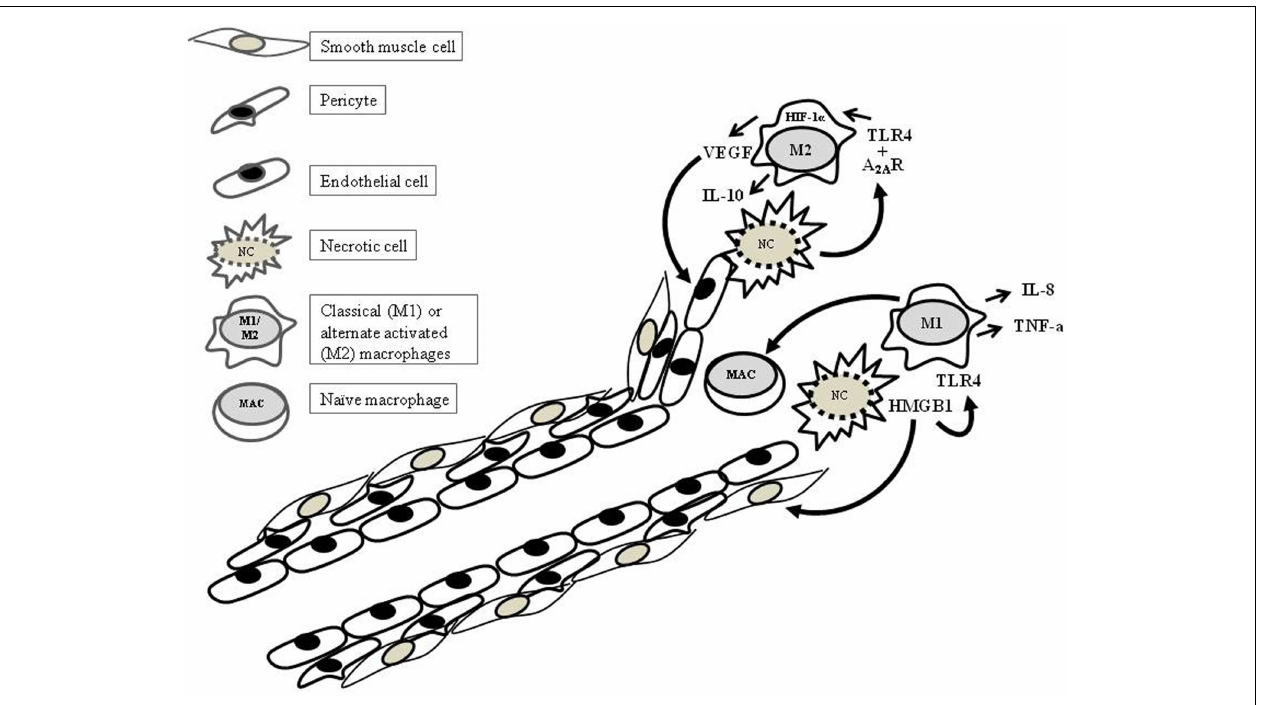
FIGURE 1 |TLR4 in postnatal angiogenesis .